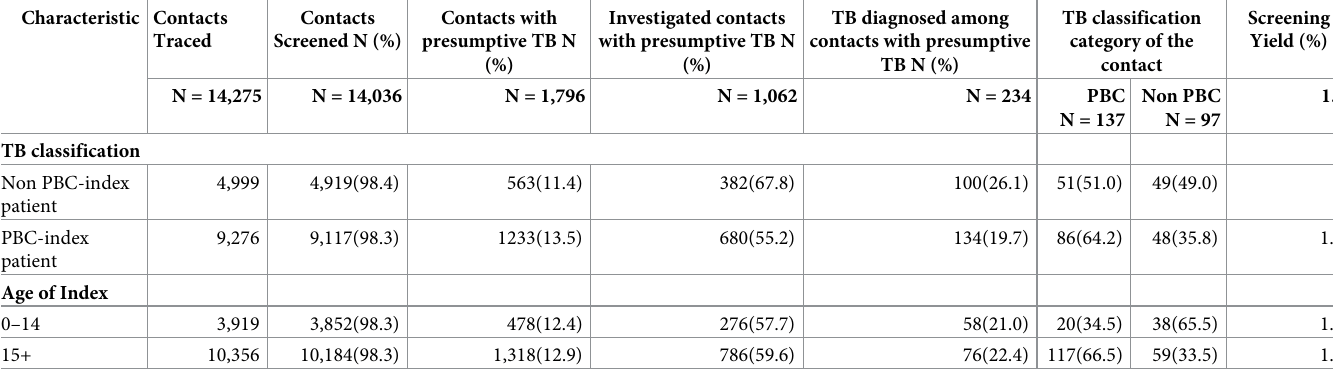
Table 2. TB screening yield among contacts of non-PBC and PBC index TB patients.